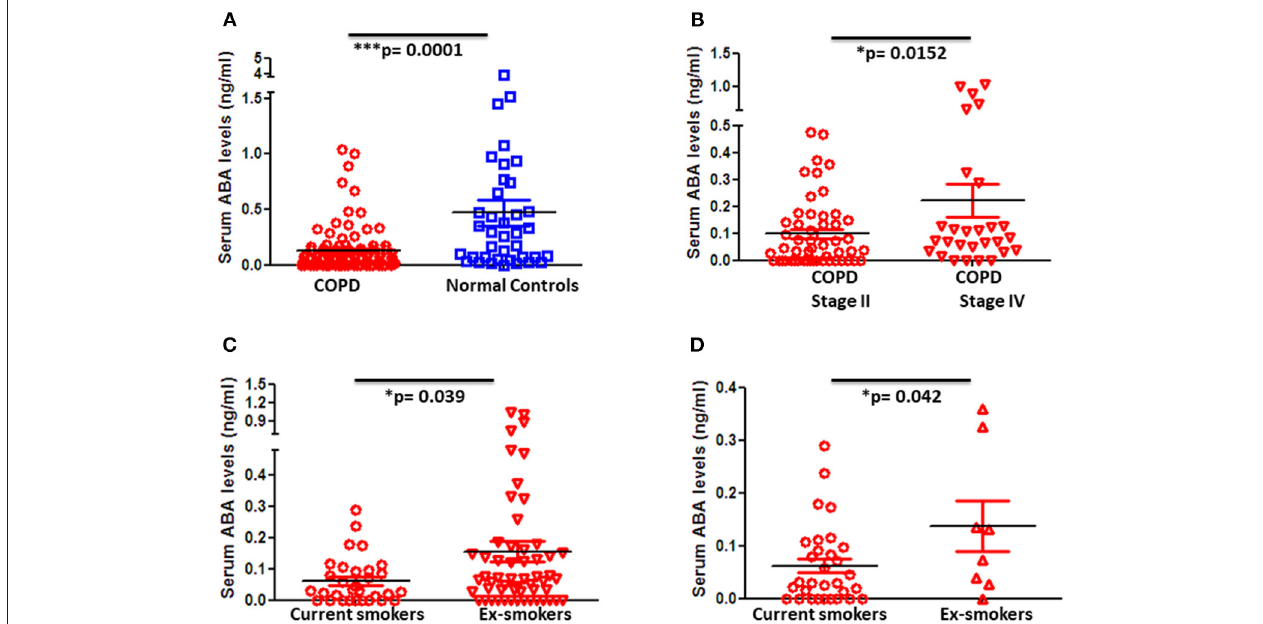
FIGURE 1 | Blood levels of ABA in patients with COPD and controls and subcategories of COPD based on disease severity and smoking habits. Circulating serum levels of ABA in (A) COPD patients ( n = 98) and age- and gender-matched controls ( n = 38), (B) GOLD classified moderate (Stage II) ( n = 52) and severe (Stage IV) ( n = 28) COPD patients, COPD patients with current smoking habits, (C) ex-smokers, and (D) and those who never smoked. Individual dots represent data obtained from individual subjects. Statistical analysis was done by either nonparametric Mann–Whitney test or unpaired Student t -test.